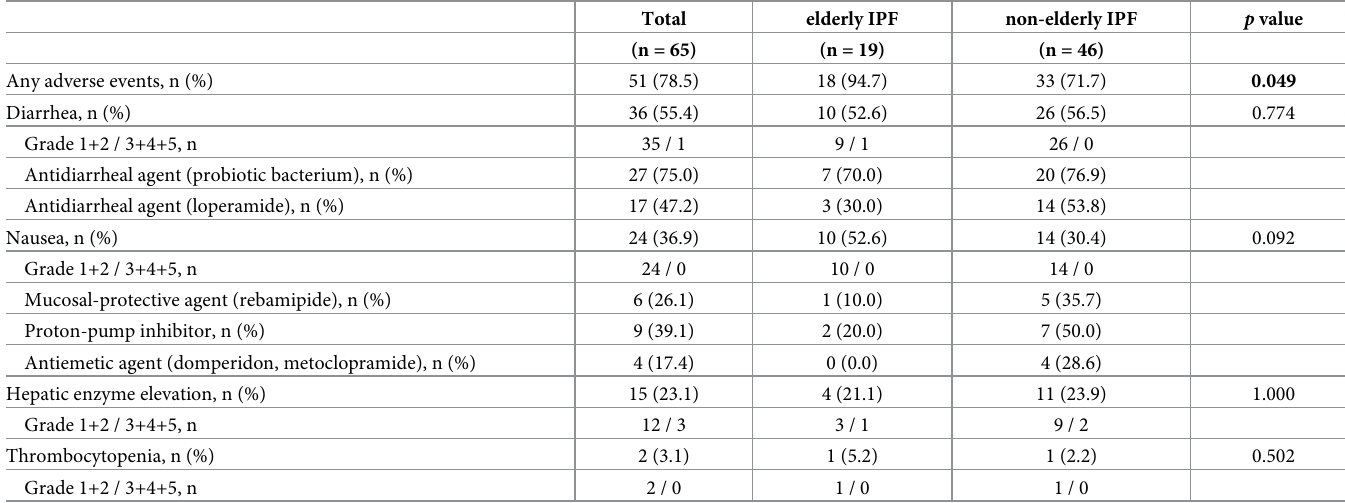
Table 3. Adverse events of nintedanib treatment.